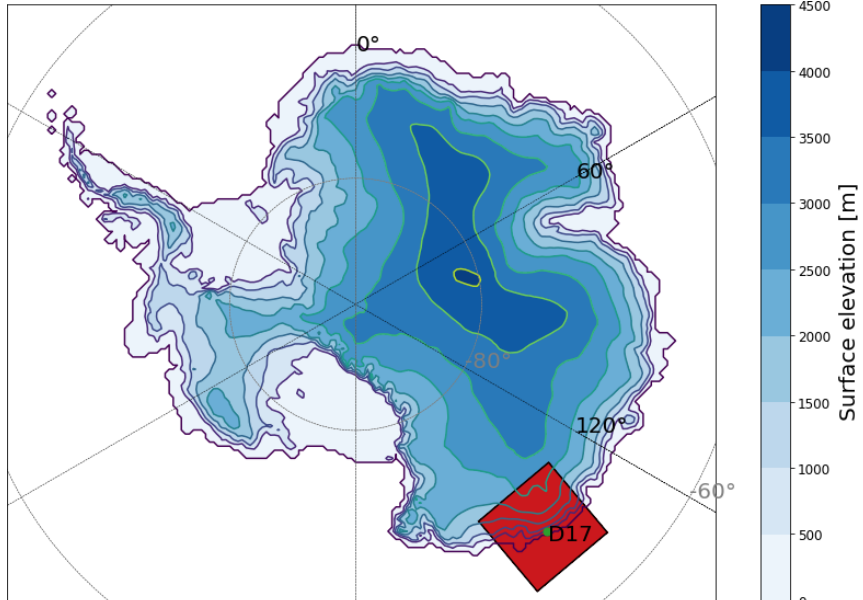
Figure 1. Antarctic topography as used in MAR. The integration domain over Adelie Land is displayed in red with a green dot for the location of